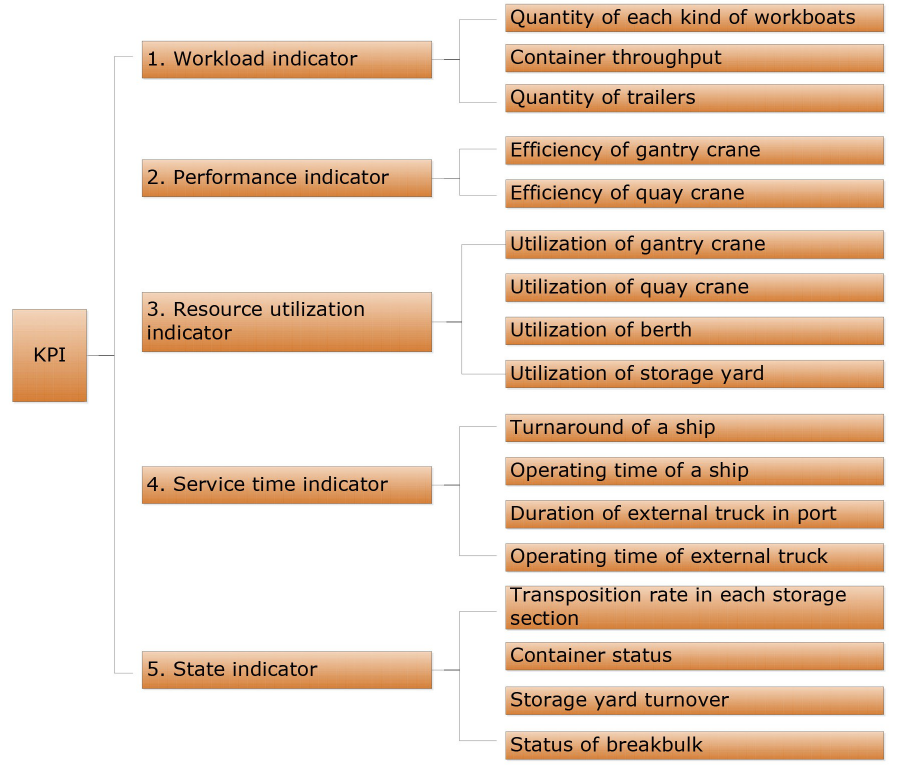
Figure 5. KPI model for performance of river